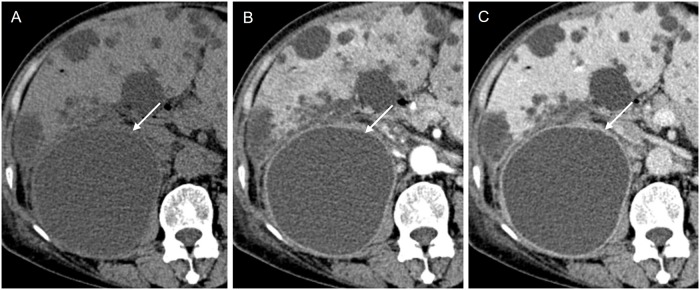
A 65-year-old female patient with an infected cyst (R24 in Fig 2).(A) Pre-contrast CT image shows a 9.7 cm sized round cyst that has higher attenuation than the surrounding cysts in right kidney upper pole (arrow). (B, C) On the arterial and portal venous phase images, the cyst shows discernible wall thickening with prominent wall enhancement and pericystic fat infiltration (arrows).